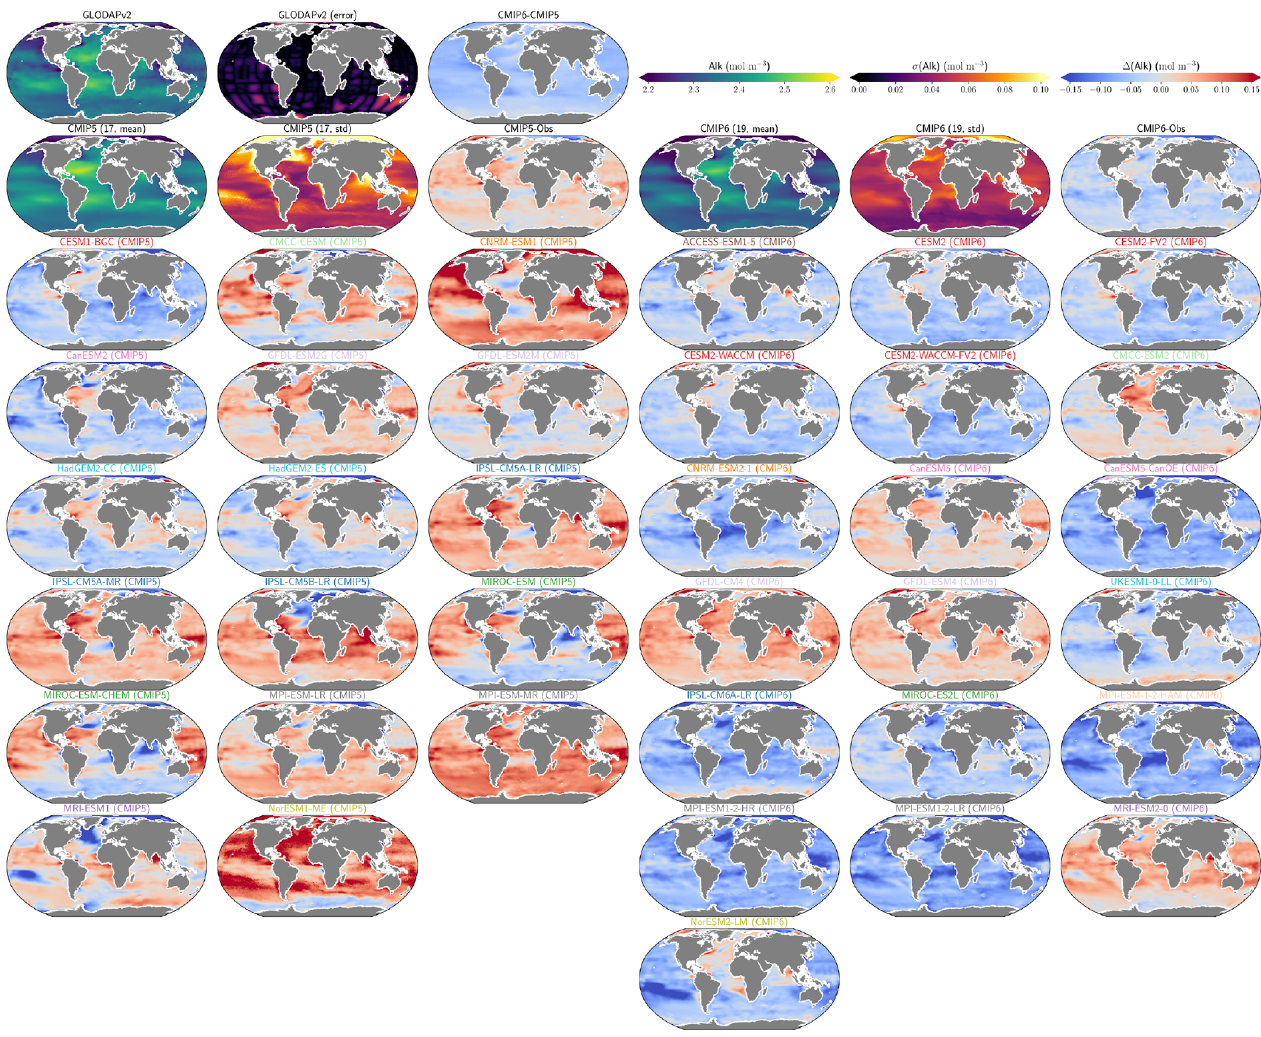
Figure D1. Alk surface distribution. ESM intercomparison of the open-ocean surface Alk as simulated by ocean biogeochemical models involved in CMIP5 (first three columns) and CMIP6 (last three columns) compared to GLODAPv2 observations. The first row gives the GLODAPv2 observational product, the associated error and the difference between the CMIP6 and CMIP5 ensemble means. The second row gives the ensemble mean, standard deviation, and observational bias for each